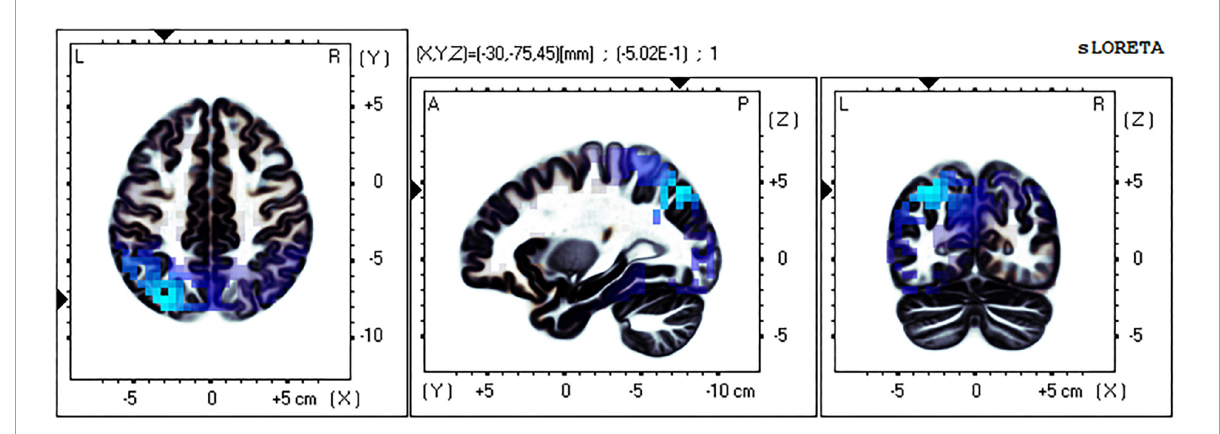
FIGURE5 Brain source localization results of current density difference corresponding to 300–500 ms ERP data of mental rotation task after sleep deprivation and before sleep deprivation under the mirror condition. Blue indicates the activation of these brain regions is significantly lower after TSD than before; Red indicates that the activation of these brain regions is significantly higher after TSD than before; from left to right: the axial, sagittal, and coronal planes, respectively. L, left; A, anterior; R, right; P,